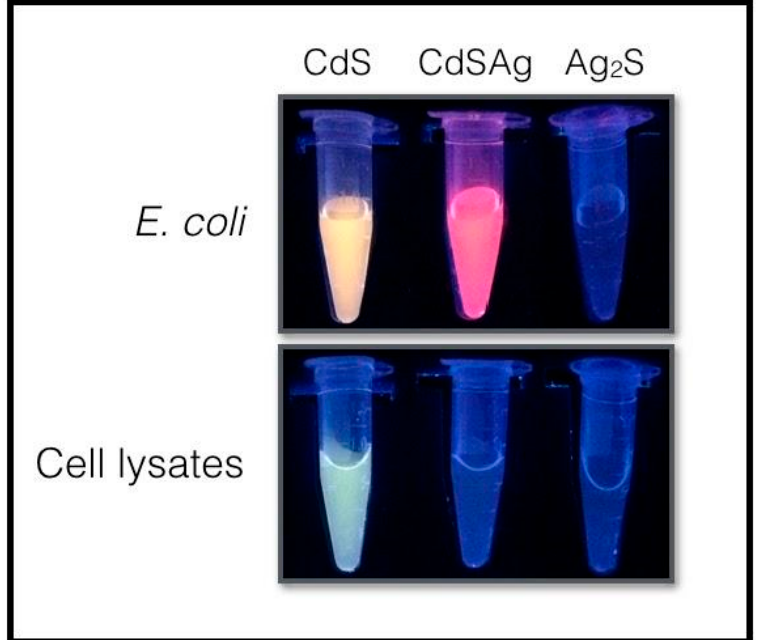
Figure 6. The synthesis of ternary cadmium / silver sulfide Quantum Dots requires living E. coli cells to occur. QDs synthesis reactions were performed in the presence of E. coli cells or cell lysates using the described CdS biosynthesis conditions (Cd 2 + and cysteine). AgNO 3 40 or 200 µ M was used to produce CdSAg or Ag 2 S NPs, respectively. Fluorescence was evaluated by exposing the tubes to ultraviolet (UV) light ( λ exc = 365 nm).